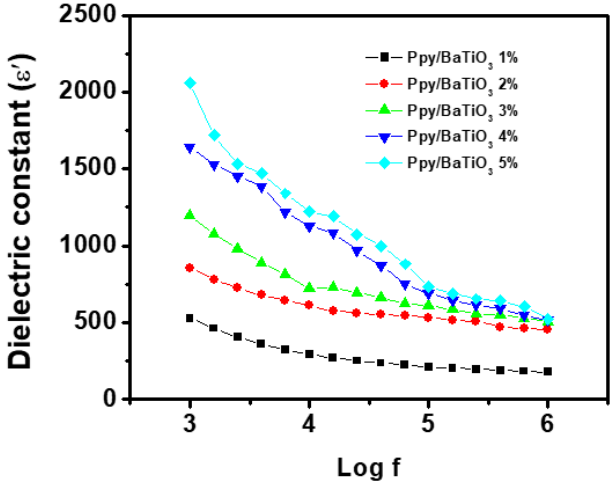
Figure 9. Dielectric constant as a function of AC frequency PPy/BaTiO 3 composites.